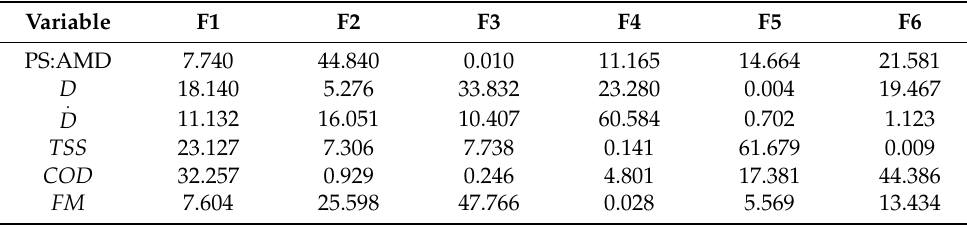
Table 8. Contribution of the studied variables (%) to each principal component. Variable